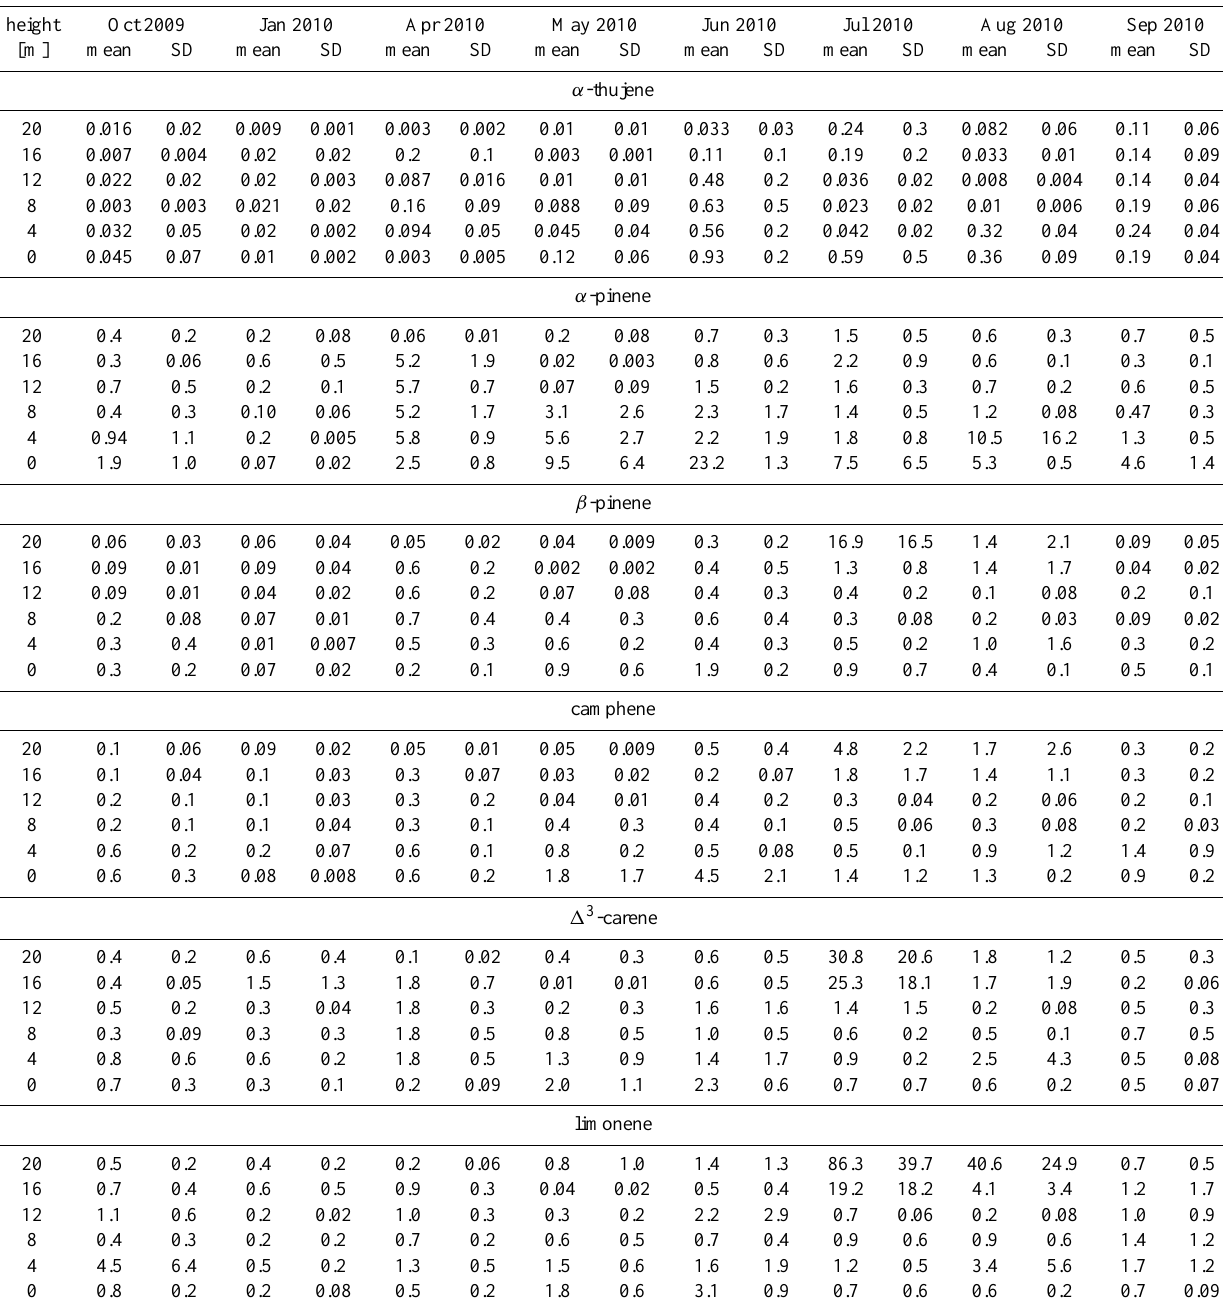
Table 3. Seasonal ambient monoterpene concentrations measured on six heights throughout the canopy. The values represent the mean and standard deviation (SD) in µgm − 3